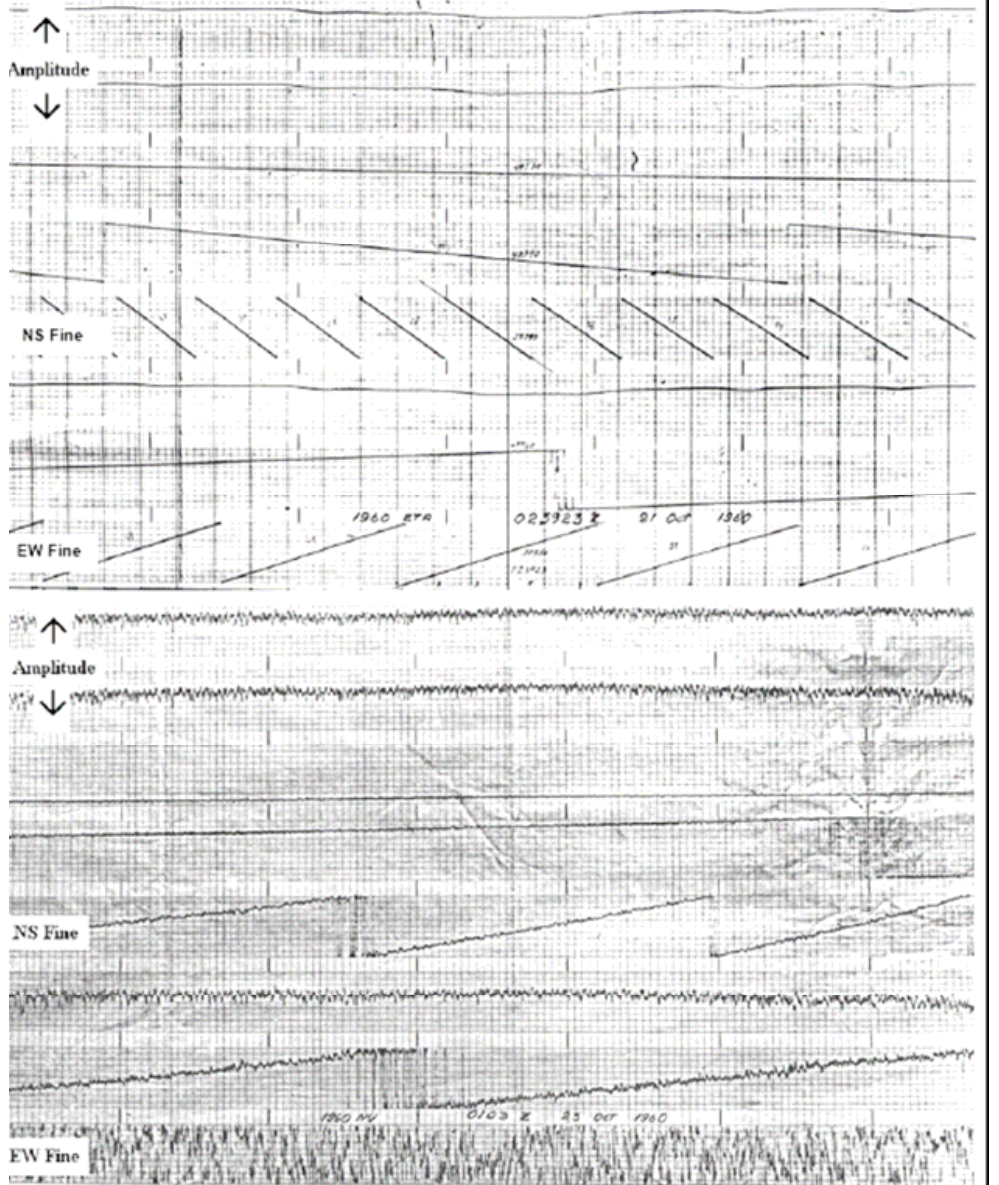
Fig. 2. Interferometric phase records taken in 1960 at Ancon, Peru, of two satellite passes: (top panel) during normal conditions, (bottom panel) during Spread F conditions. There are four record channels of interest on each (out of the eight shown), the top 2, showing the amplitude (log scale), and the interferometric phase (0 to 2 π , corresponding to 1 ◦ of physical angle) for the NS and EW Fine base lines. Notice the strong phase scintillations in the EW channel in panel b ) while the NS channel is undisturbed. Both fine base-line amplitudes (top channels) showed amplitude scintillations (adapted from Woodman, 1960)